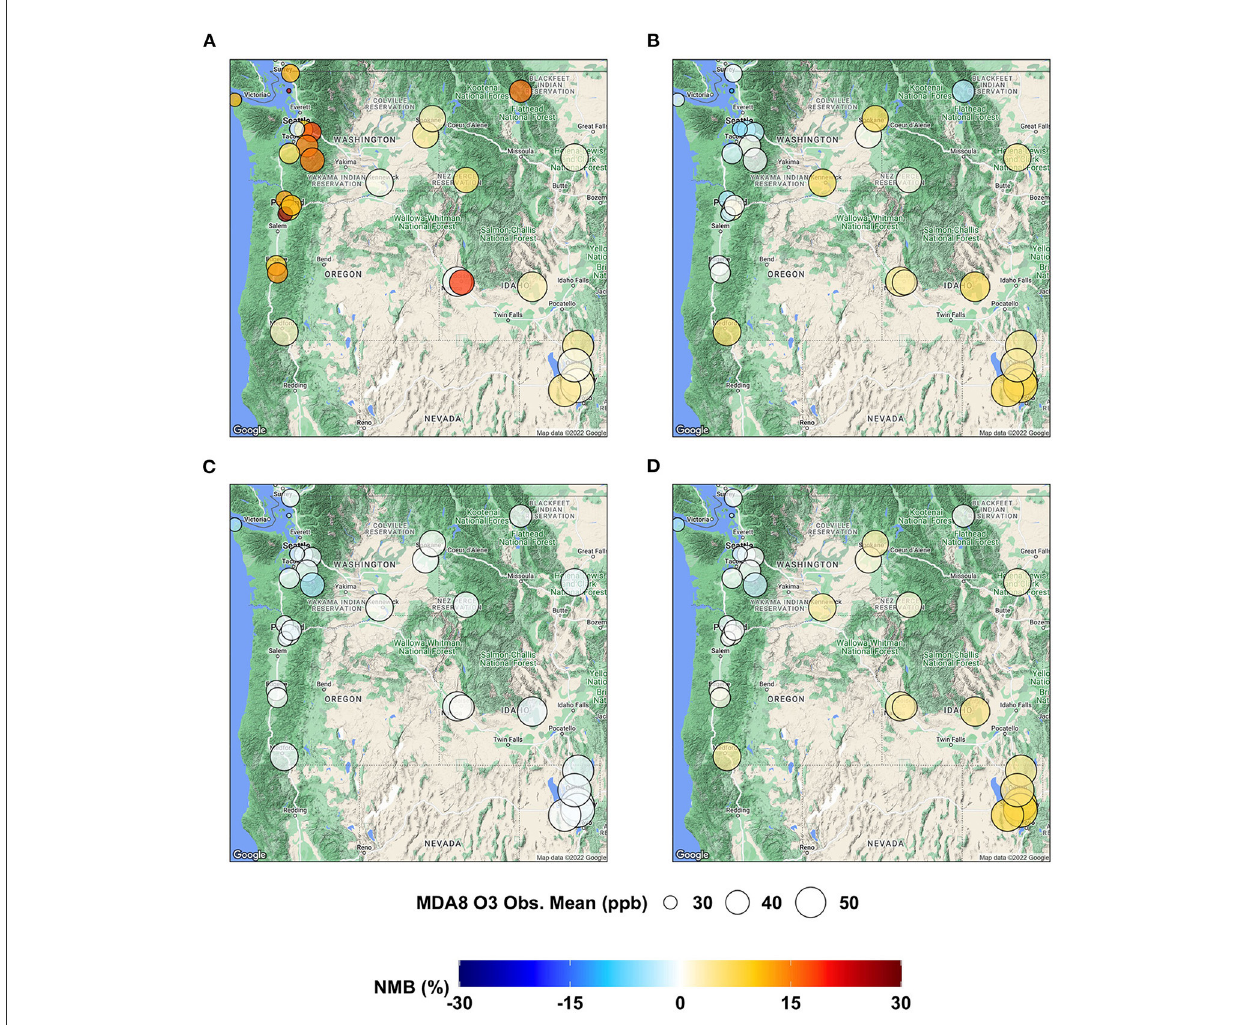
FIGURE3 Maps showing NMB of MDA8 O 3 predictions from (A) AIRPACT, (B) ML1, (C) ML2, and (D) ML_opr_O 3 at the AQS sites throughout the PNW.